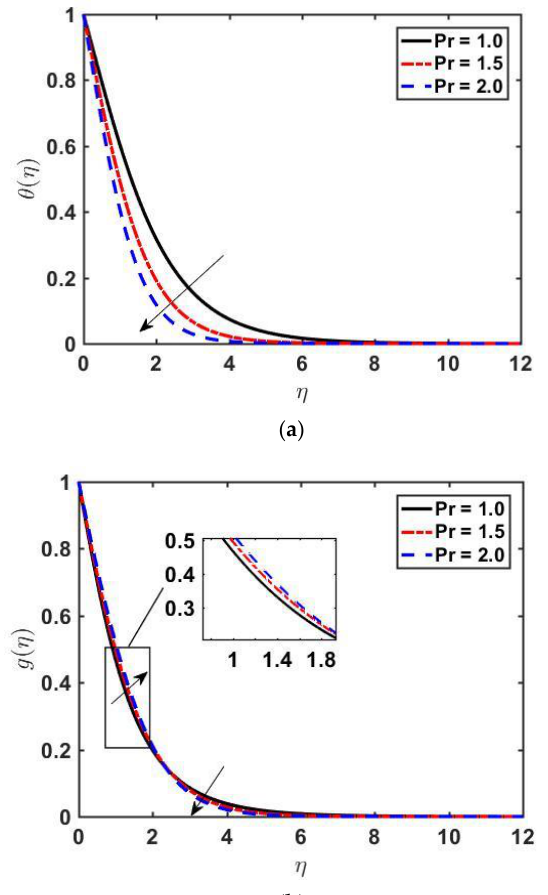
Figure 4. Profiles of θ ( η ) and g ( η ) versus η for various values of Pr by fixing λ = 0.3, M = 0.5, Le = 3.0, Nbt = 2.0, Nc = 0.5, and Sc = 2.0.